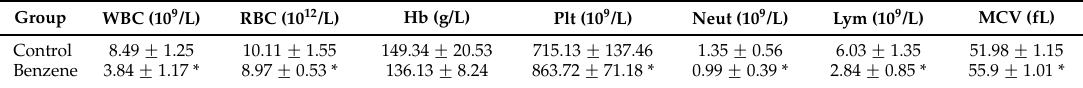
Table 2. Blood parameters of mice in benzene exposure and control